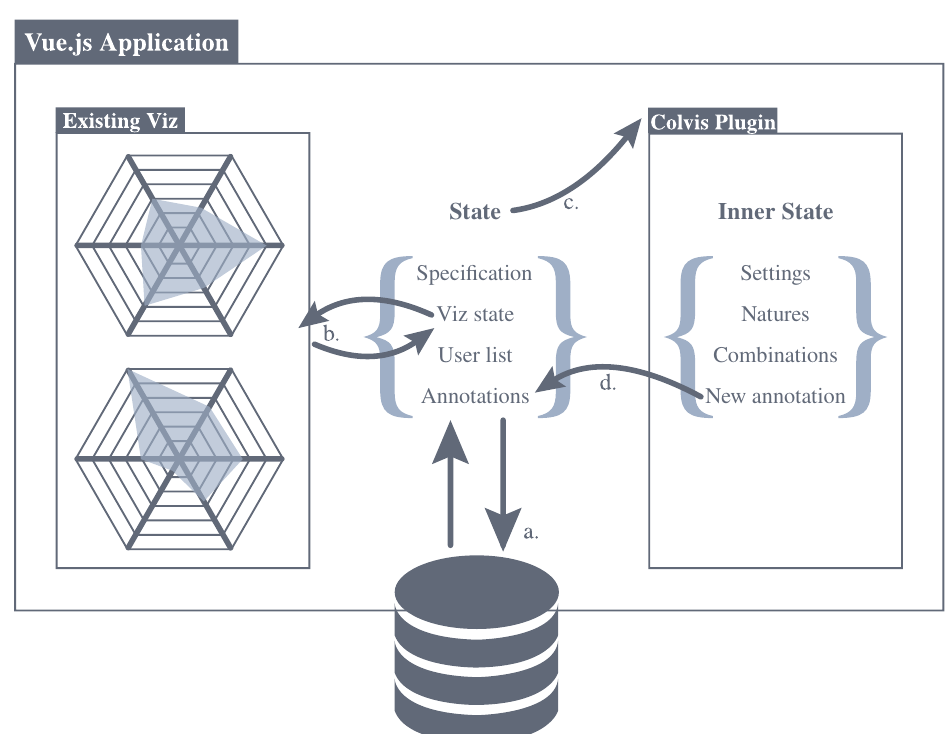
Figure 3. The plugin resides within a Vue.js application that encompasses one or several existing visualizations. ( a ) A database sends information to populate the state of the application. ( b ) The visualization changes state through user interactions. ( c ) The application communicates its state, including the specification, to the interface. ( d ) As the annotator submits an annotation, the interface returns it to the main application as a JavaScript